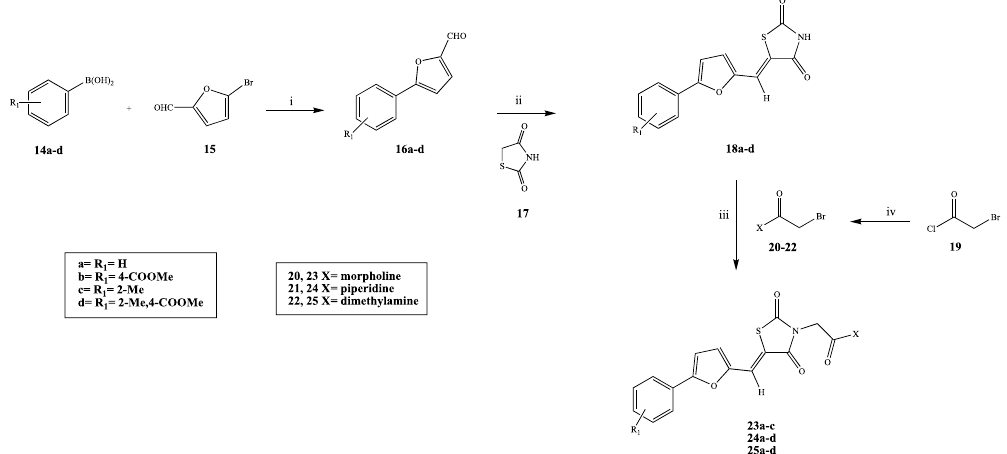
Figure 5. General synthetic procedure followed for the preparation of 23a-c, 24a-d, 25a-d. (i) Na 2 CO 3 , for counter-screening. The three compounds (green bars) were examined using the gel-based assay due to the unusual behaviour of demonstrating higher inhibition at 10 µ M compared to 100 µ M, potentially due to solubility issues. Two additional compounds (AE-562/12222591 and AK-968/41925073) demonstrated more than 25% inhibition at 10 and 100 µ M but were not pursued further as they both precipitated heavily in 100% DMSO and therefore lacked the desirable drug-like property of solubility. In this assay, a 32 nucleotide RNA template (PE44-NoV) is extended to 44 nucleotides in the presence of an active RdRp 16 . The NA 3 ′ -deoxyguanosine-5 ′ -triphosphate (3 ′ dGTP) was used as a positive control and exhibited